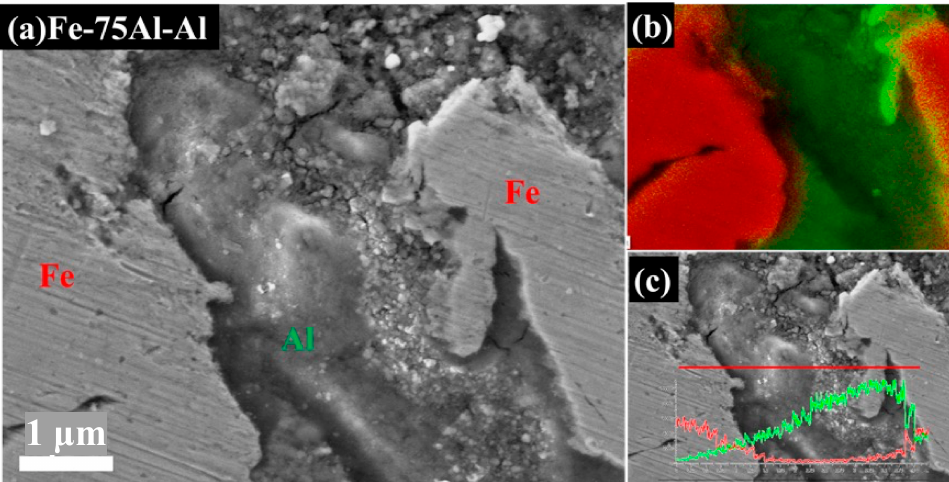
Figure 4. ( a ) SEM image of Fe ‐ 75Al ‐ Al; ( b ) EDS mapping elemental analysis (red region is Fe and green region is Al); ( c ) line scan analysis (red and green lines represent the variations in the Fe content and Al content, respectively).